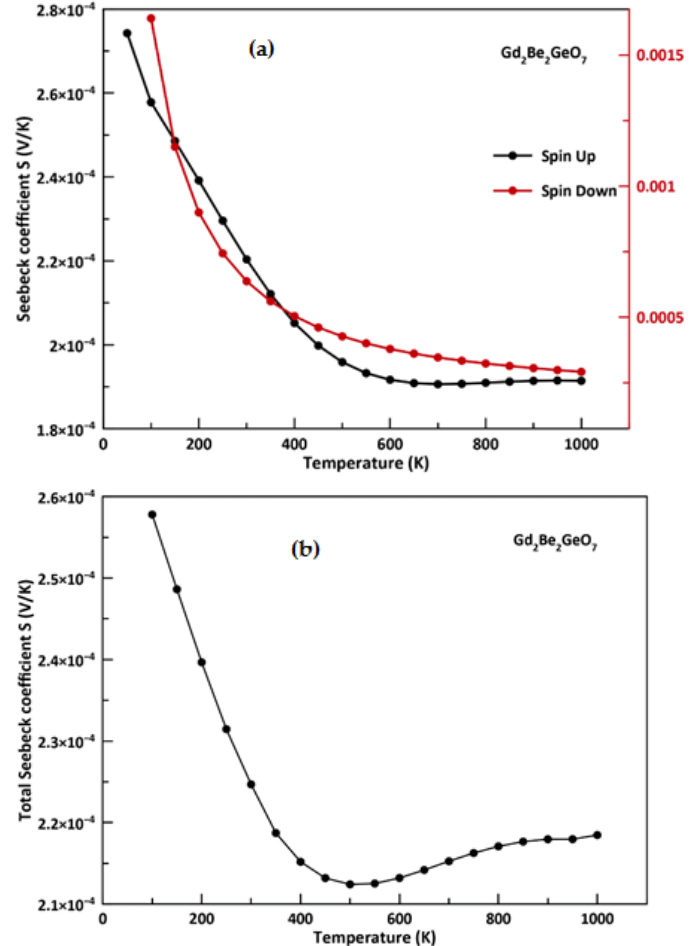
Figure 13. ( a ) Calculated total Seebeck coefficient (S) as a function of temperature for Gd 2 Be 2 GeO 7 compound in both spin channels (up and down); ( b ) Calculated total Seebeck coefficient (S) as a function of temperature for Gd 2 Be 2 GeO 7 compound .